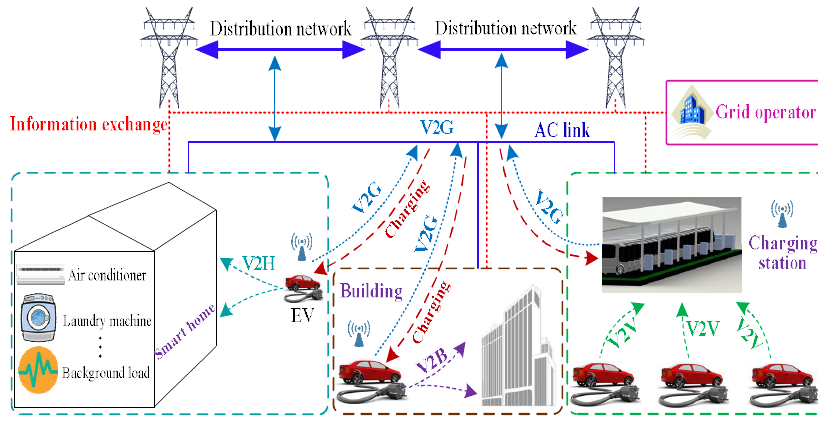
Figure 1. Overview of V2A paradigm.